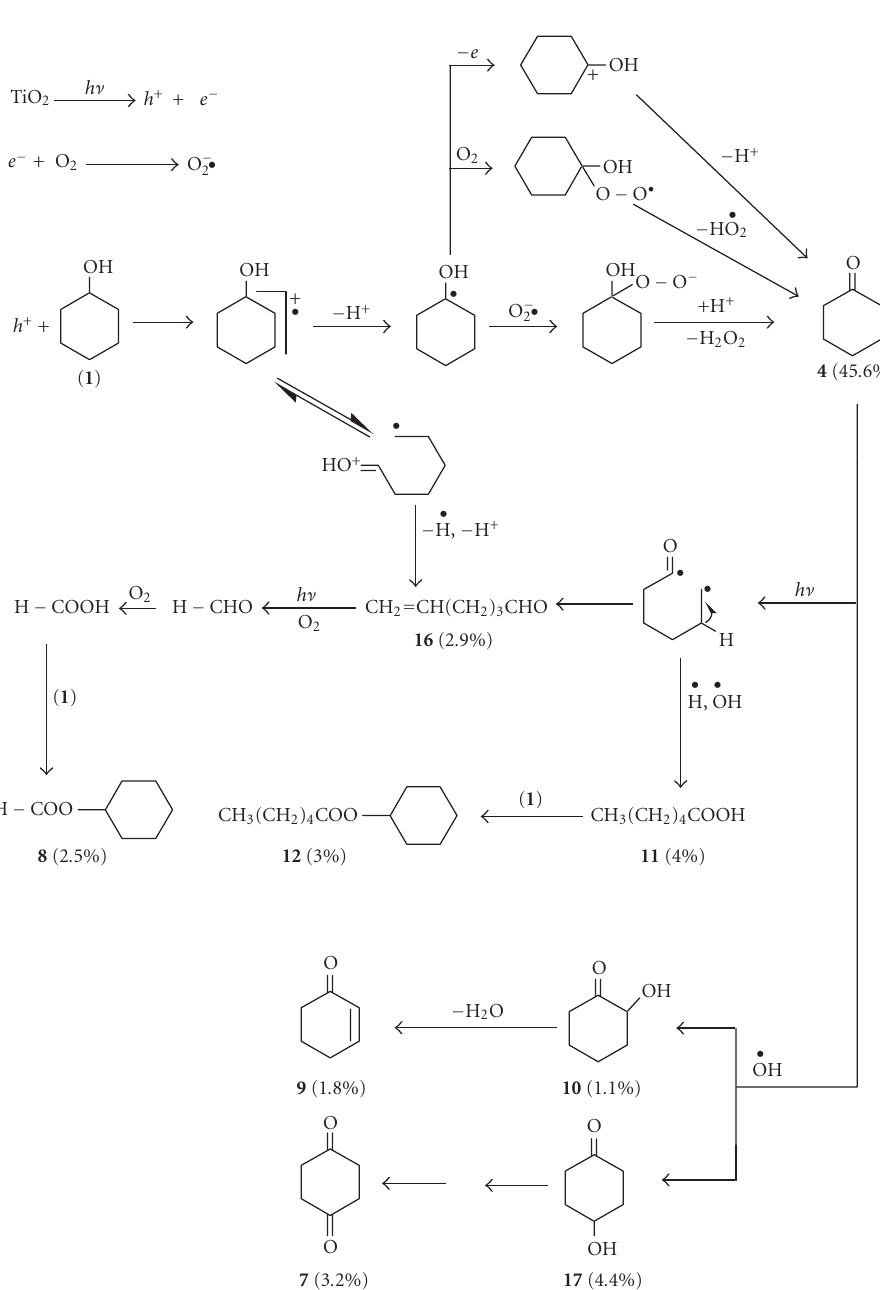
Scheme 1: Suggested mechanism of PCO of 1 in